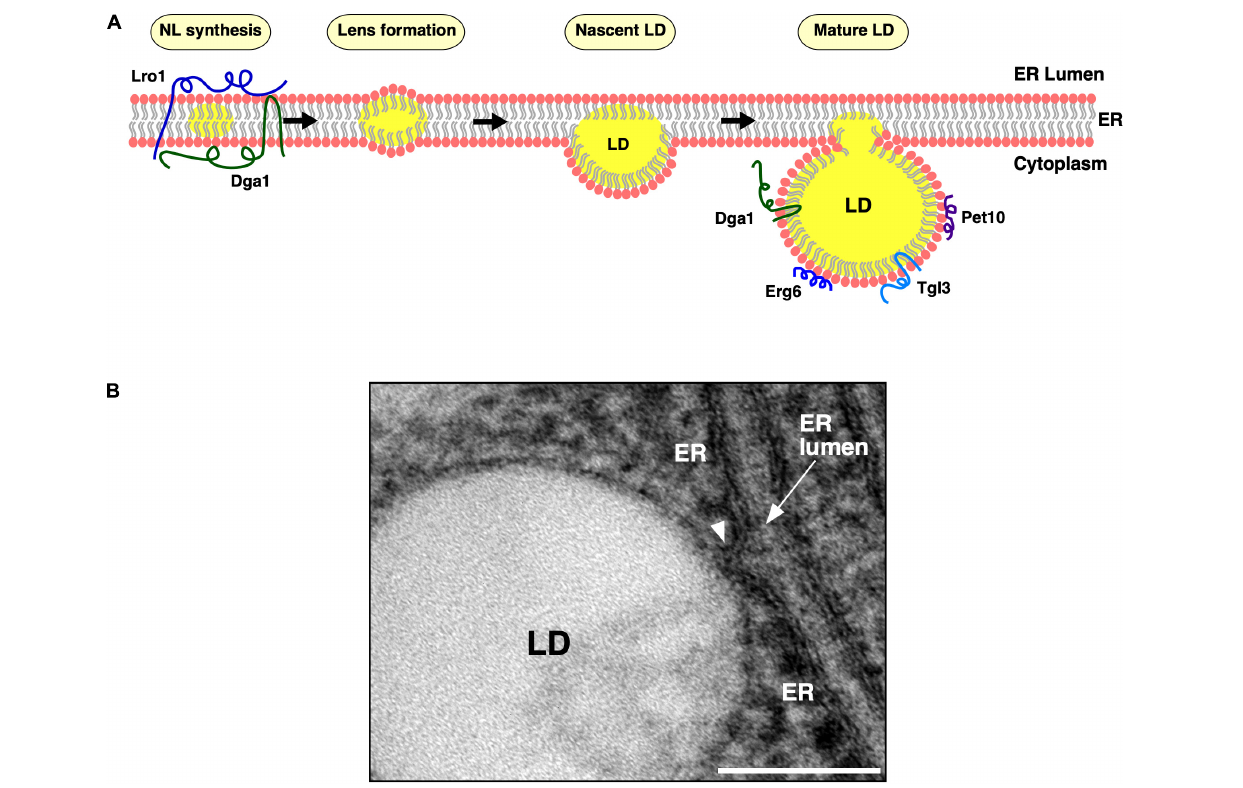
FIGURE 1 | Lipid droplet (LD) biogenesis from the endoplasmic reticulum (ER) membrane. (A) Model of LD biogenesis. ER residential triacylglycerol-producing enzymes, Dga1 and Lro1, catalyze production of neutral lipids (NLs, shown in yellow) within the lipid bilayer of the ER membrane. Upon reaching a concentration threshold, NLs coalesce and form lens-like structures. NL lenses acquire more NLs, grow into nascent LDs, which then emerge toward the cytoplasm and further mature in their protein composition. Mature LDs remain connected to the cytoplasmic leaflet of the ER membrane at ER–LD contact sites. The TAG-synthase, Dga1, and the TAG-lipase, Tgl3, then translocate from the ER bilayer onto the LD monolayer of mature LDs. Finally, LD scaffolding proteins, such as the perilipin ortholog, Pet10, and the sterol biosynthetic enzymes, such as Erg6, localize to the periphery of mature LDs. (B) Morphology of the ER–LD junction. Ultrastructural visualization of the continuity between the ER bilayer membrane and the LD surface. ER, endoplasmic reticulum; LD, lipid droplet. Scale bar, 0.1 µ